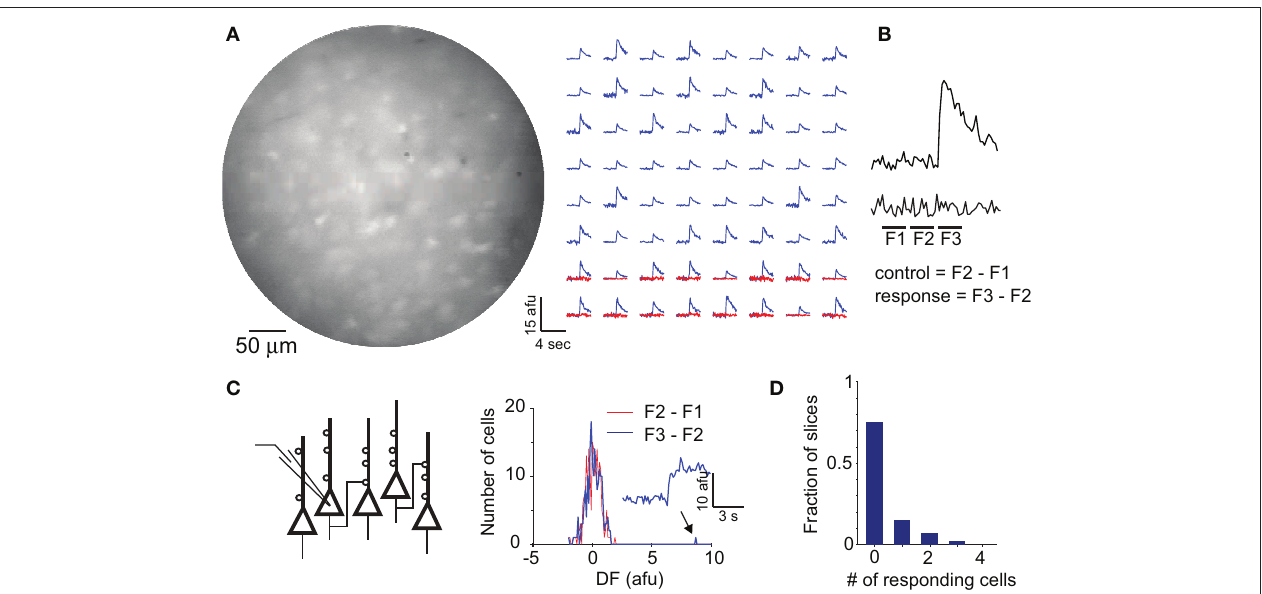
F3. Noise estimates were obtained from the difference in fluorescence during periods F2 and F1. (C) A single neuron was stimulated to emit 5 action potentials at 20Hz under whole-cell patch mode, and calcium signals were imaged in neighboring cells. Histogram of response amplitudes (blue) for 150 cells from one such experiment revealed just one cell with a clear response (arrow, and associated fluorescence trace). Noise distribution for the same experiment is shown in red. (D) Distribution of the number of responding cells from all experiments. Note that most experiments had 0 responding